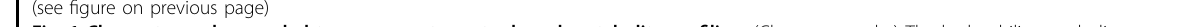
Fig. 1 Chromatography coupled to mass spectrometry-based metabolite pro fi ling. (Chromatography) The hydrophilic metabolites are separated by chromatography based on their chemical properties. For LC, the types of stationary phase and mobile phase, and the gradient of and composition of the mobile phase must be optimized to facilitate the optimal separation of metabolites of interest. In contrast, prior to GC-based separation, the metabolites must be derivatized to be volatile. Because the volatile-derivatized metabolites only interact with the stationary phase of the column and not the chemically inert gas mobile phase, the column oven temperature gradient needs to be optimized to achieve optimal metabolite separation. (Mass spectrometry) The separated metabolites are ionized and discriminated via mass spectrometry based on their molecular mass to charge ratio (m/z). The identity of metabolites is further determined by comparing with an authentic standard. (Metabolite ID) LC – MS analysis: after ionization by ESI, the ions with the same retention time can be discriminated via their MS/MS fragmentation (in triple Q) or via high- resolution mass accuracy (in Q-TOF or Orbitrap). In contrast, for GC – MS analysis, the metabolite ion speci fi city is based on their dissociation fragment pattern following EI-based hard ionization. TCA tricarboxylic acid, SGOC serine, glycine, and one carbon, LC liquid chromatography, GC gas chromatography, ESI electrospray ionization, EI electron (impact) ionization, Q-TOF quadrupole-time of fl ight, ACN acetonitrile; MeOH methanol, m/z mass to charge ratio, M(B)STFA N -methyl- N (or N , O -bis)-(trimethylsilyl) tri fl uoroacetamide, MTBSTFA N -(tert-butyldimethylsilyl)- N - methyltri fl uoroacetamide, RT retention time, CE collision